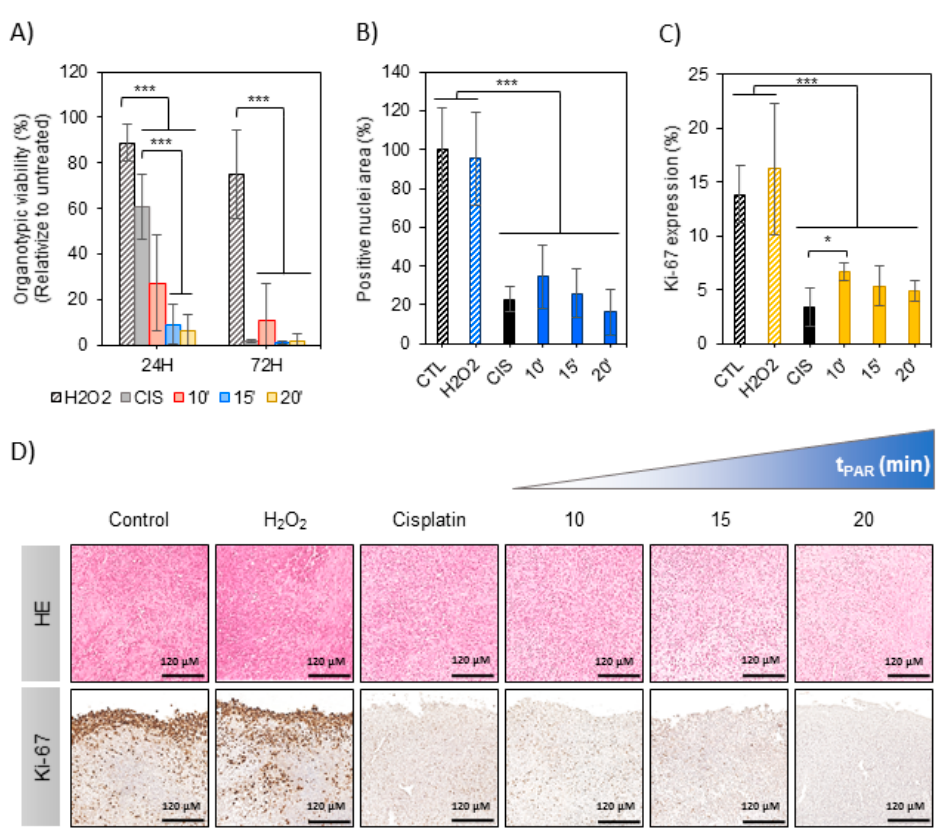
Figure 5. PAR effects in mouse organotypic OS model. Mouse OS tumor sections in floating culture were treated with PAR at increasing treatment times (10, 15 and 20 min) or by 100 µM of Cisplatin (CIS) or 500 µM of H 2 O 2 . ( A ) Metabolic activity was determined by resazurin 24 and 72 h after PAR exposure. In this assay, four sections were analyzed per condition, and the assay was performed in three independent experiments. Values were relativized to tumor sections exposed to untreated PAR. Tumor sections were fixed 72 h after treatment and processed for histological analysis. Samples were stained with haematoxylin/eosin (HE) and immunostained for Ki-67. ( B ) HE quantification of positive nuclei stained areas (values relativized to control). ( C ) Percentage of positive Ki-67 stained nuclei. For statistical analysis, 5 well-distributed images were taken at X40 and were analyzed. Asterisks represent statistically significance between different conditions ( n = 3; * p -value < 0.05; *** p -value < 0.005; ANOVA and two-sided Student’s t -test). ( D ) Representative images for HE and Ki-67 immunostaining for each condition (Scale bar = 120 µm). 3. Discussion We report here on the effects of saline solutions activated by plasma in 2D adherent and on 3D organotypic OS cultures, employing a clinically compatible Ringer’s saline. Cold atmospheric plasmas have been highlighted as a potential therapy against many types of cancers. However, most studies up to now were conducted in vitro (95%), mostly in 2D cultures, and only 26% evaluated the effects of plasma-activated liquids on the cells (as opposed to directly treating the cells with plasma) [44]. The direct application of plasma and the homogeneity of the treatment may depend on tumor size and body location, restricting the possibility of treating tumors hard to reach. Employing plasma- activated liquids can allow injection to the tumor site, and thus provide a minimally invasive approach for this therapy [11]. The reactivity transfer from the plasma gas phase to the liquid phase has been highlighted as being of prime importance for its biological effects [21]. Despite employing here two jets that use noble gases (Helium in APPJ or Ar in kINPen), an important part of the reactivity of these jets derives from mixing of the plasma gas phase with air. The gas phase of the APPJ during treatment of Ringer’s